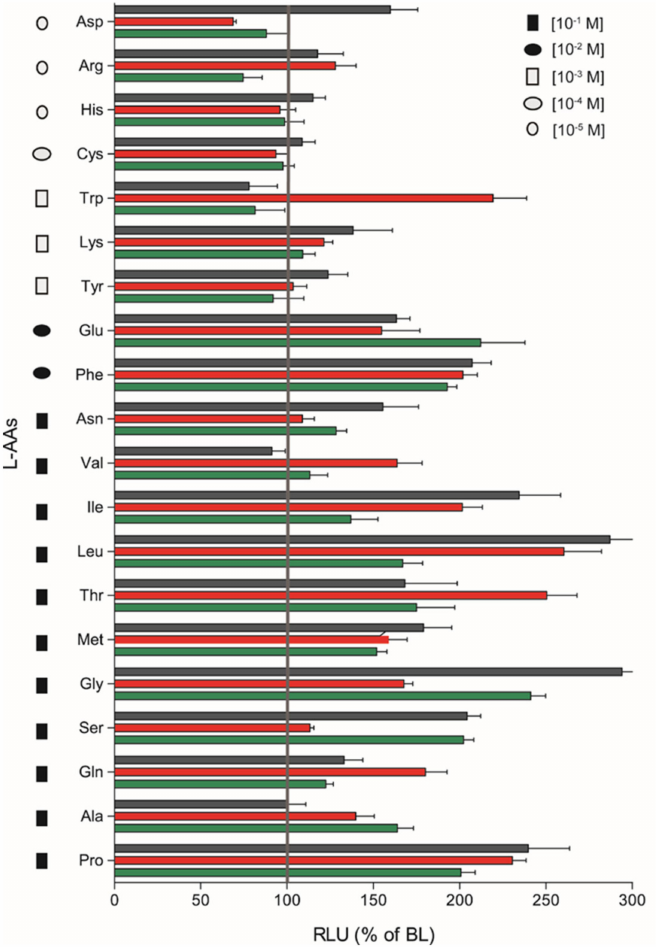
Figure 7. Magnitudes of saT1R1 / R3 , saT1R2a / R3 and saT1R2b / R3 responses (green, red and black bars, respectively) to L-AAs based on RLU recorded at maximal stimulation dosages (MSD) within molar range concentrations of (10 − 1 –10 − 5